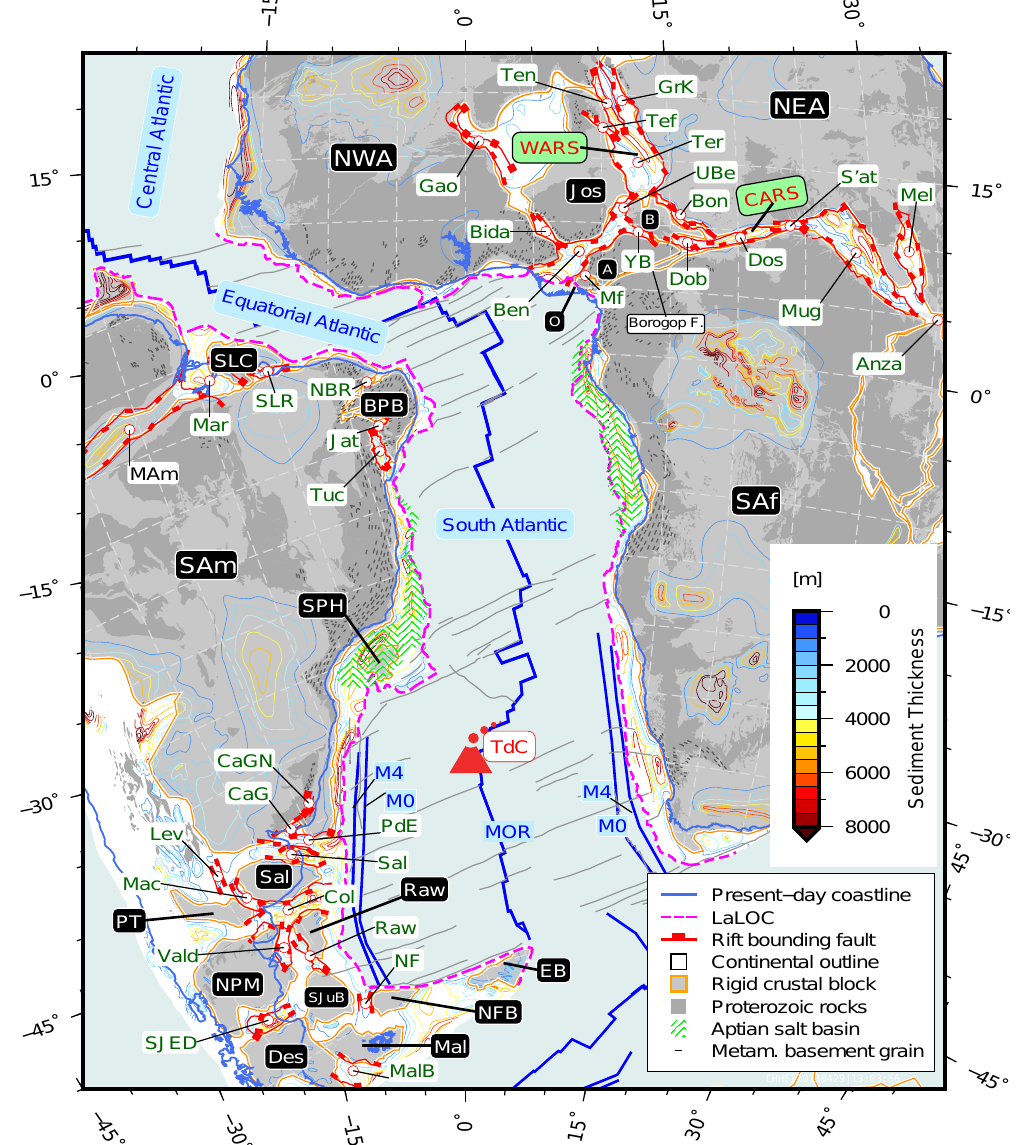
Fig. 1. Rigid crustal blocks, Jurassic–Cretaceous rift structures, and sediment isopachs, reconstructed to 83.5Ma position (magnetic anomaly chron C34y) with Africa held fixed in present coordinates using the rotation poles of N¨urnberg and M¨uller (1991). Proterozoic rocks are based on United States Geological Survey (2012), metamorphic basement grain as thin white lines (Exxon Production Research Company, 1985). Oceanic fracture zones are shown as grey lines. Tristan da Cu˜nha hotspot (TdC) indicated by volcano symbol. Rigid crustal blocks denoted as black boxes, rift basins outlined by red fault symbols and denoted in green font and white boxes. Abbreviations: A – Adamaoua